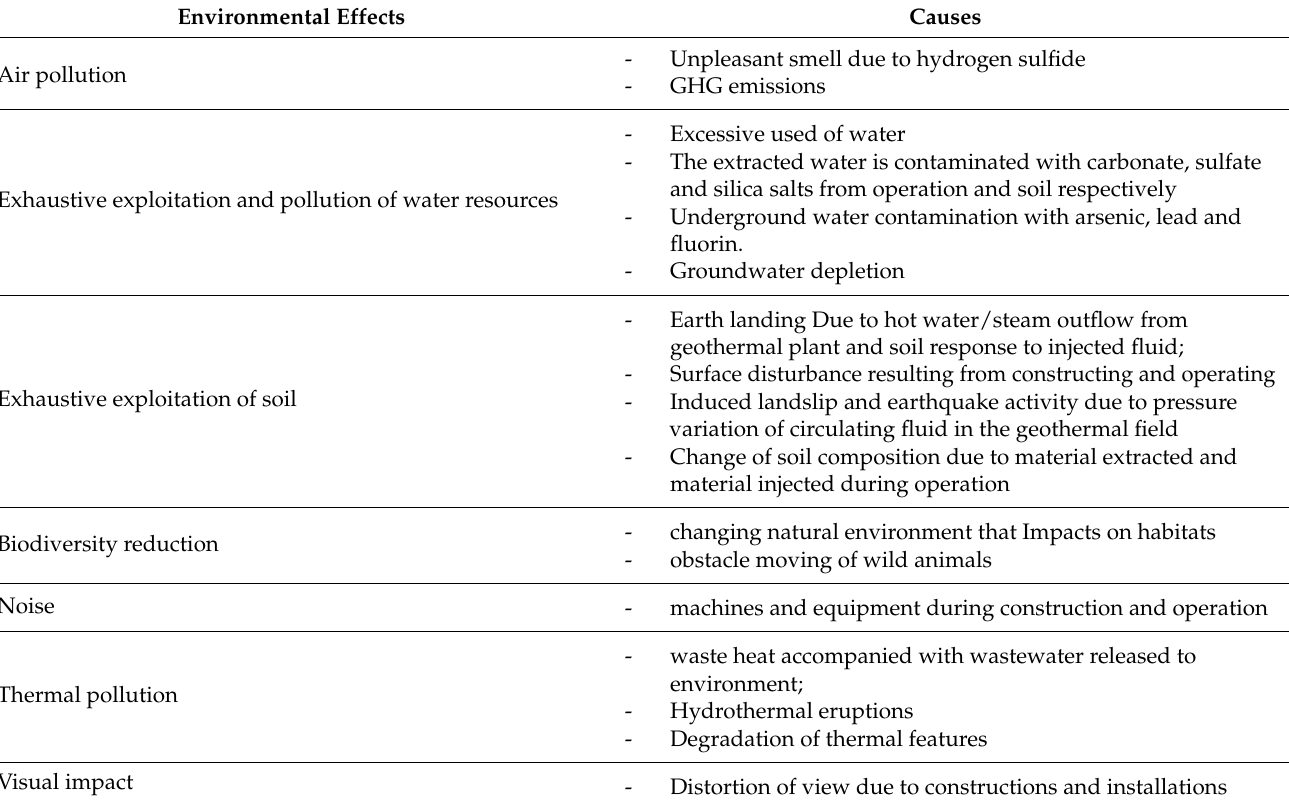
Table 4. Geothermal power plant environmental effect and